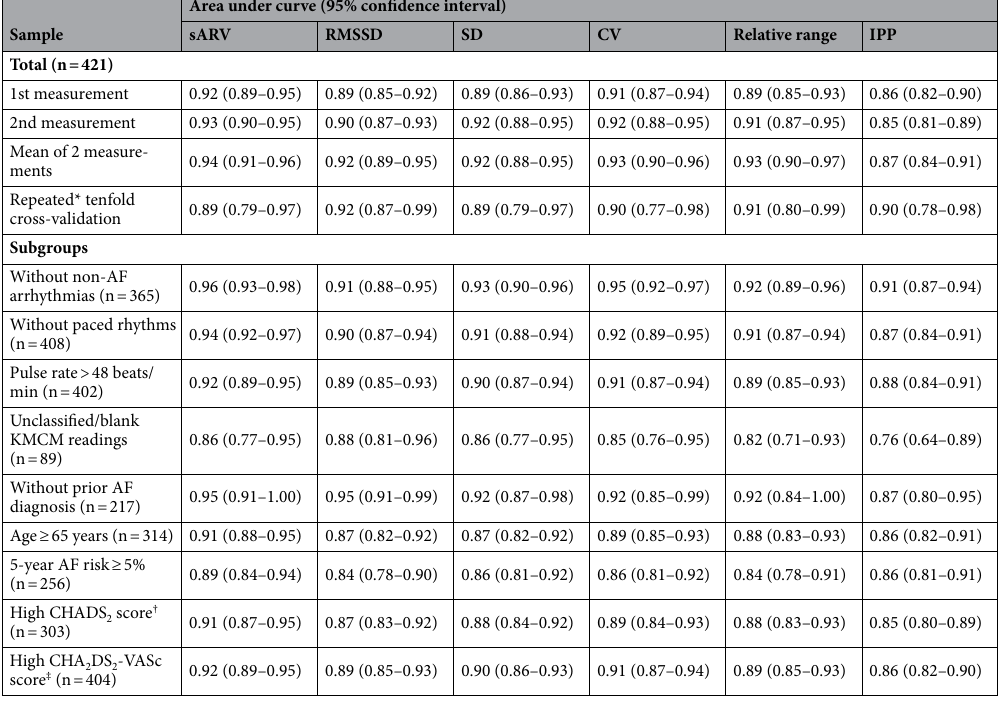
Table 2. Discrimination performance of pulse rate variability parameters for detecting AF. AF atrial fibrillation, CV coefficient of variation, IPP irregular pulse percentage, KMCM Kardia Mobile Cardiac Monitor, RMSSD root mean square of successive differences, sARV standardised average real variability, SD standard deviation. *10 times. † CHADS 2 score ≥ 2; ‡ CHA 2 DS 2 -VASc score ≥ 1 (males) or ≥ 2